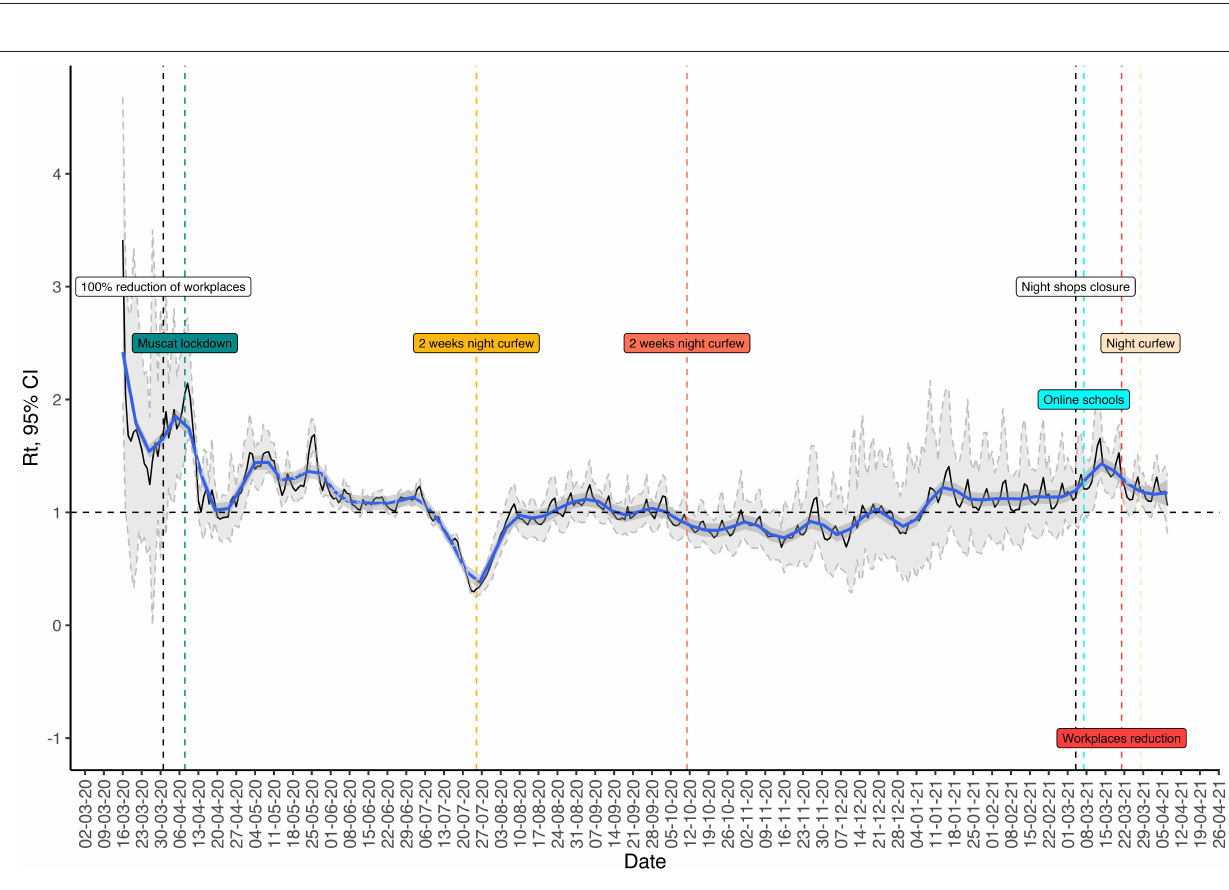
Frontiers in Public Health |